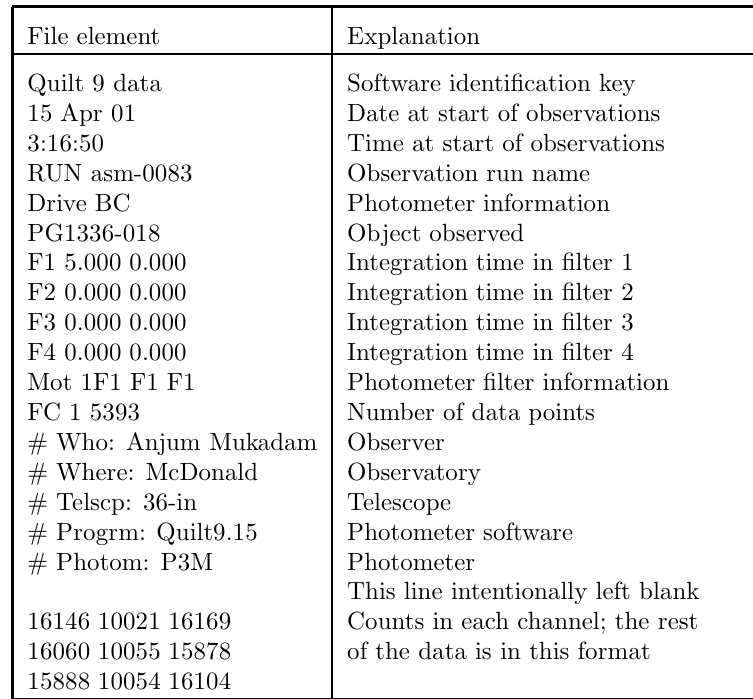
Table 1. The Quilt 9 data file format. The left column is an actual Quilt 9 observation file from XCov21, and the right gives an explanation of each line of the